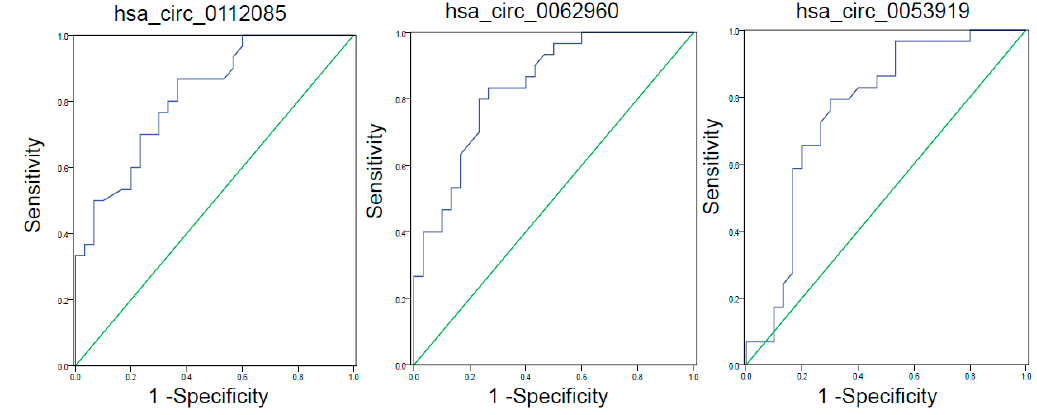
Figure 3. Receiver operating characteristic (ROC) curve analyses of circRNAs. The area under the curve (AUC) values are given on the